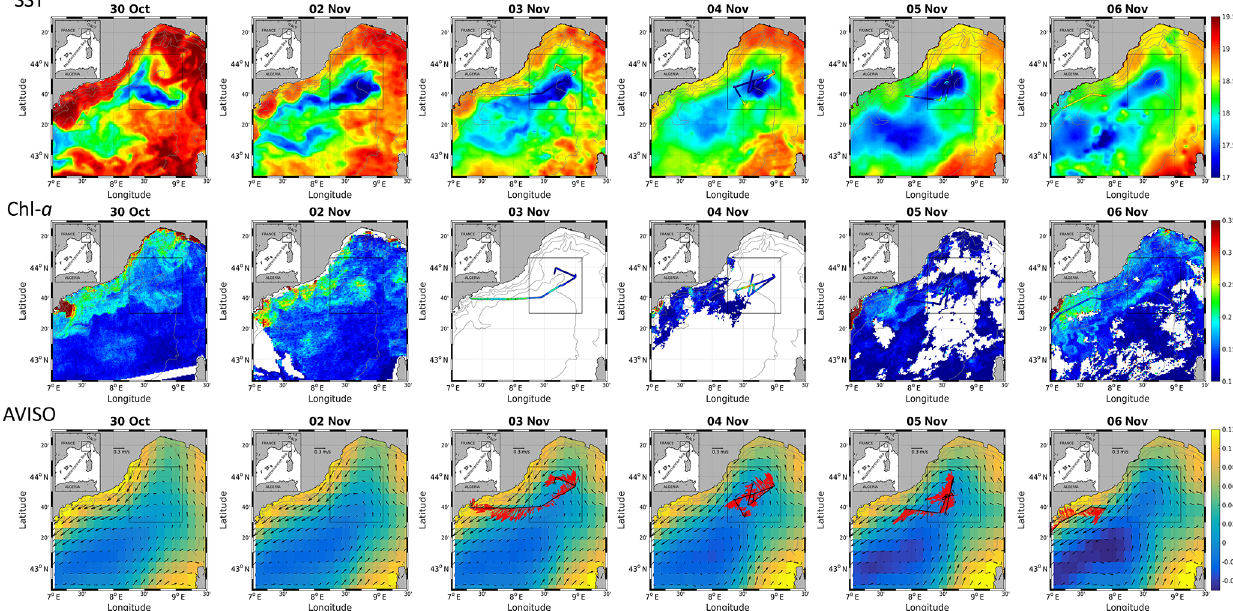
Figure 1. Sea surface temperature (SST, in ◦ C), Chl a concentration (in µgdm − 3 ) and AVISO altimetry (in cm) and derived current intensity (ms − 1 ) and direction in the Ligurian subbasin from 30 October to 6 November. The black box represents the study area. From 3 November to 6 November, SST and Chl a continuous surface measurements were superimposed on the satellite products and ADCP currents were represented in the AVISO